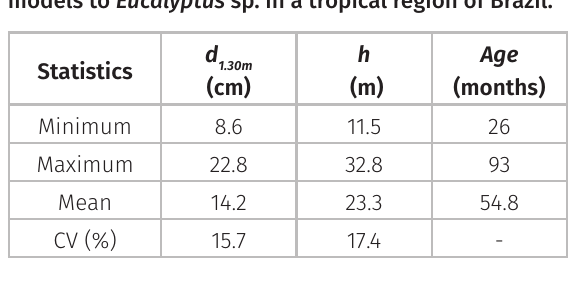
Table I. Characteristics of the variables for adjusting models to Eucalyptus sp. in a tropical region of